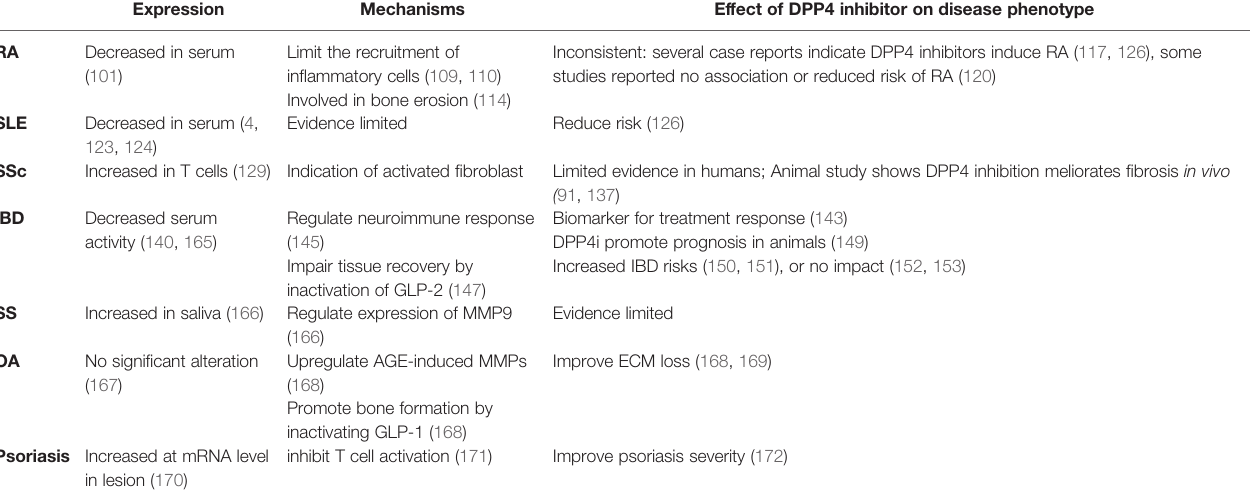
TABLE 3 | The role of DPP4 in autoimmune diseases. Expression